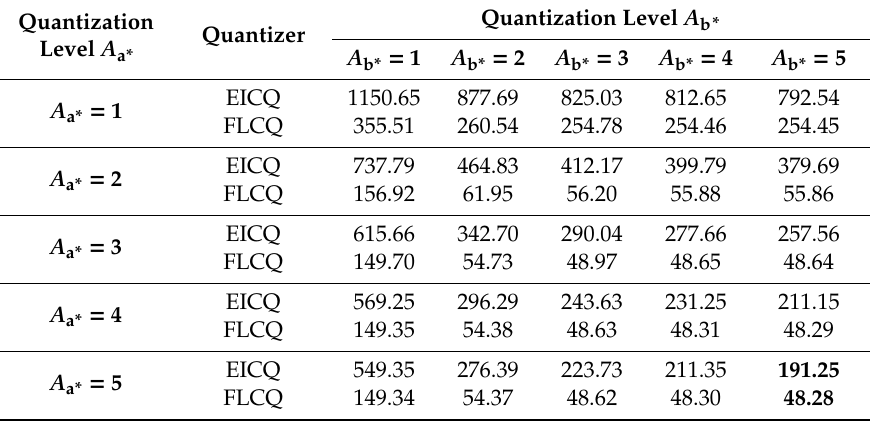
Table A1. The mean square error of the EICQ and FLCQ quantizers on Face-95. Quantization